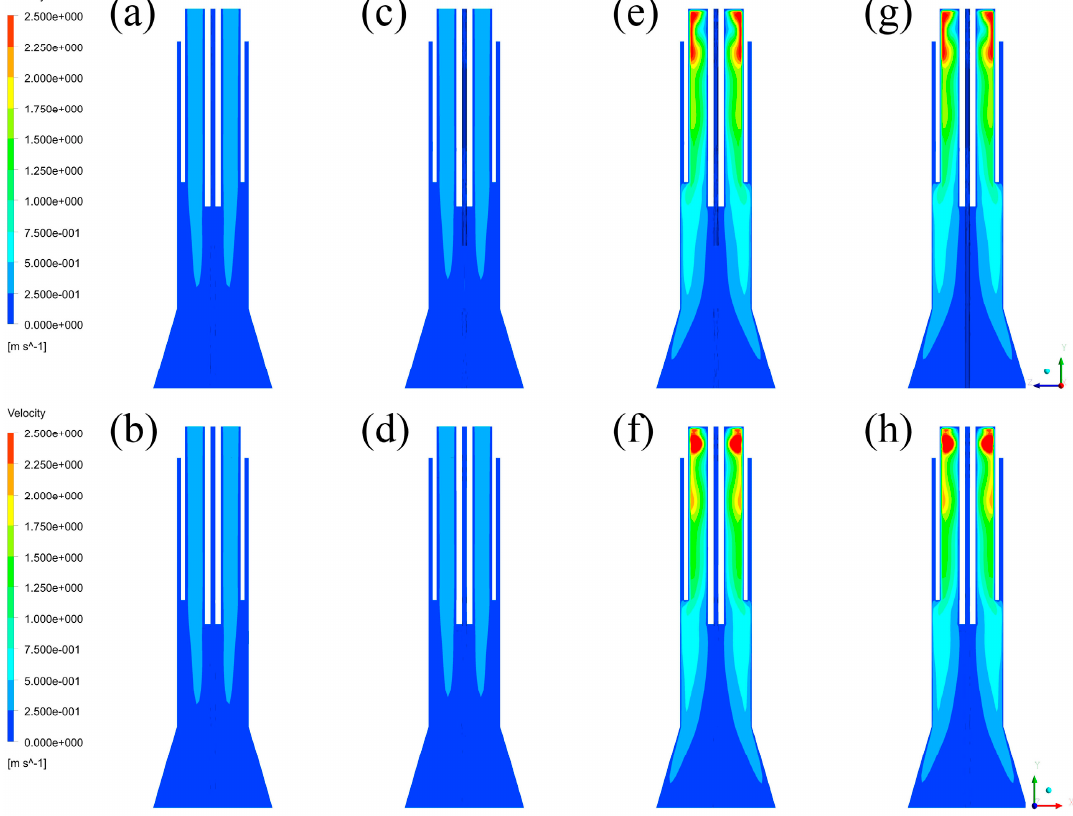
Figure 8. Velocity fields without plasma torch: ( a ) Case A in YZ plane, ( b ) Case A in XZ plane, ( c ) Case B in YZ plane, ( d ) Case B in XZ plane, ( e ) Case C in YZ plane, ( f ) Case C in XZ plane, ( g ) Case D in YZ plane, ( h ) Case D in XZ plane.